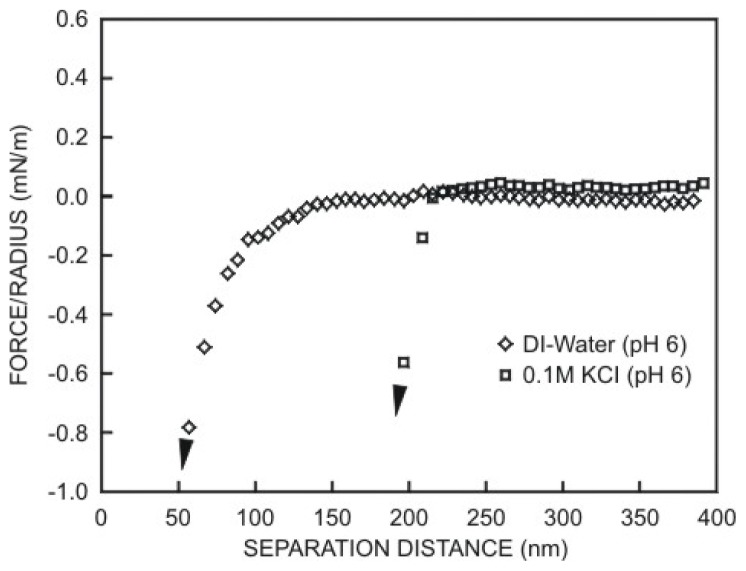
Interaction between hydrophobic surfaces (Reproduced by permission of Elsevier [387].